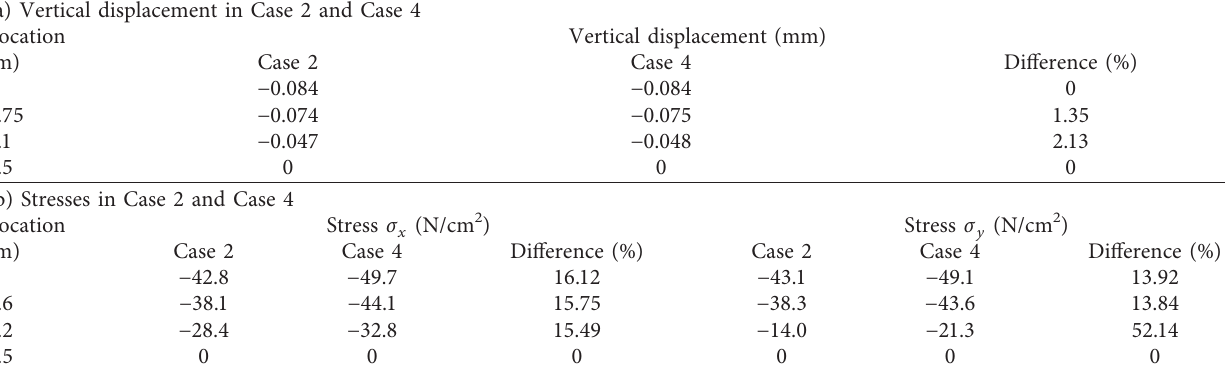
Figure 15: Vertical displacement and stresses in Case 2 and Case 4: (a) vertical displacement of shell in Case 2 and Case 4; (b) stress σ shell in Case 2 and Case 4; (c) stress σ y of shell in Case 2 and Case 4. Table 6: Vertical displacement and stresses values in